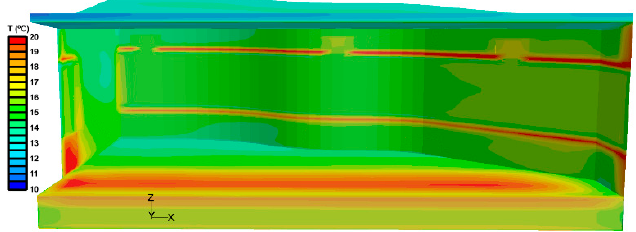
Figure 6. Temperature contours on the interior surfaces: vertical partition, sand floor and ceiling. Date: 15th March at 11:00 a.m.; solar irradiation 597.43 W/m 2 ; exterior temperature 9.8 °C.